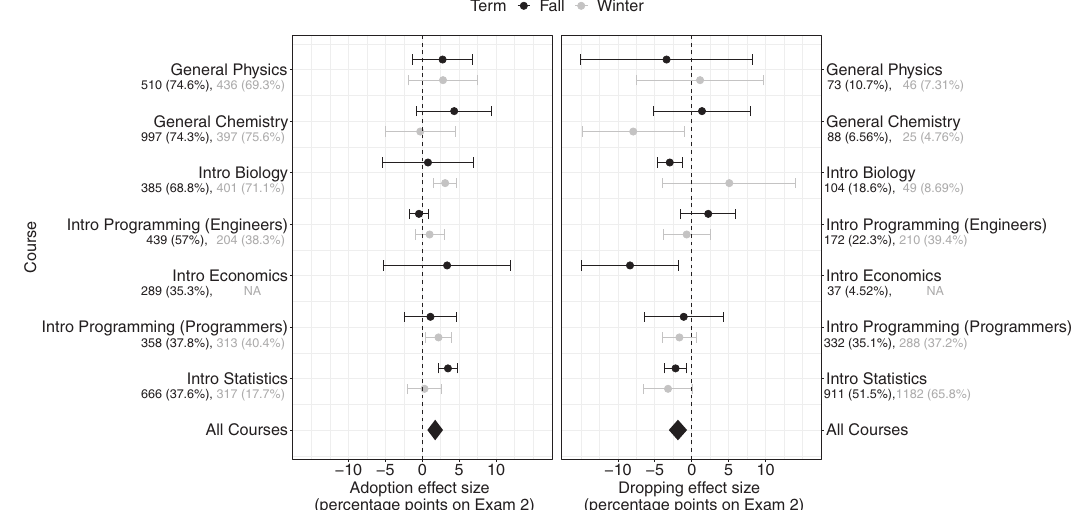
Fig. 2 Meta-analysis of the Effect of Adopting and Dropping the Exam Playbook. Note. Forest plot showing effect sizes from strati fi ed matching analyses. Numbers below each course name indicate the number of students in that analysis (and as a percentage of the total class). Left: Effect of “ adopting ” the Exam Playbook. Both groups did not use the Exam Playbook at Exam 1; students who used it on Exam 2 outperformed students who did not. Right: Effect of “ dropping ” the Exam Playbook. Both groups used the Exam Playbook for Exam 1; students who dropped the Exam Playbook at Exam 2 did worse than students who consistently used it. Error bars re fl ect 95% con fi dence